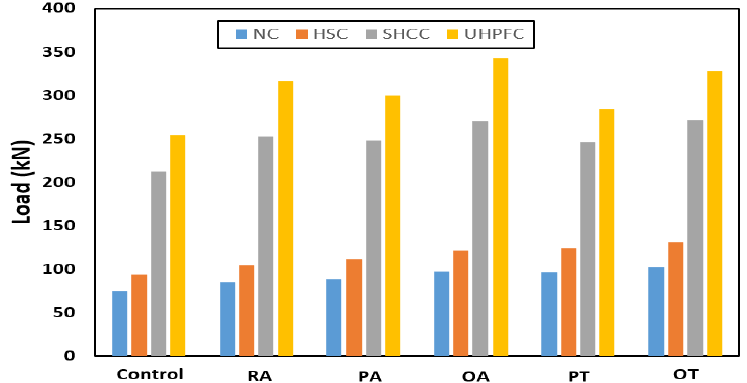
Figure 12. Ultimate loads for different tested specimens.